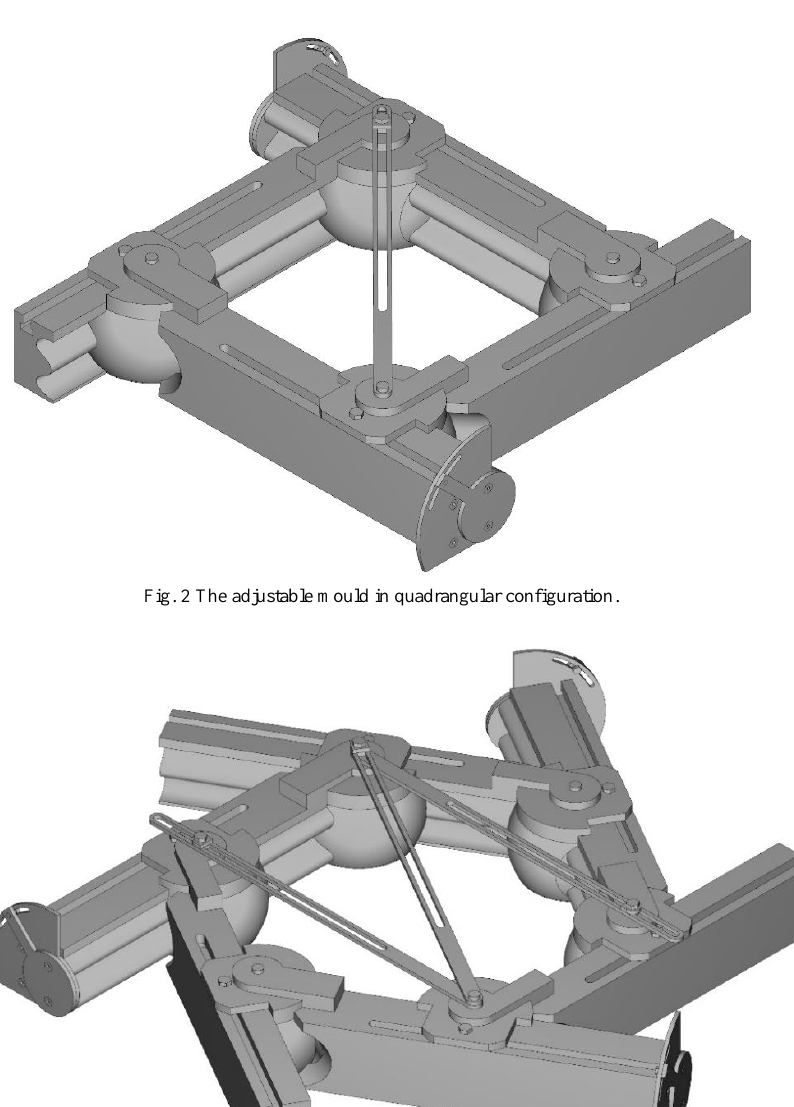
Fig. 1 The adjustable mould in triangular configuration.